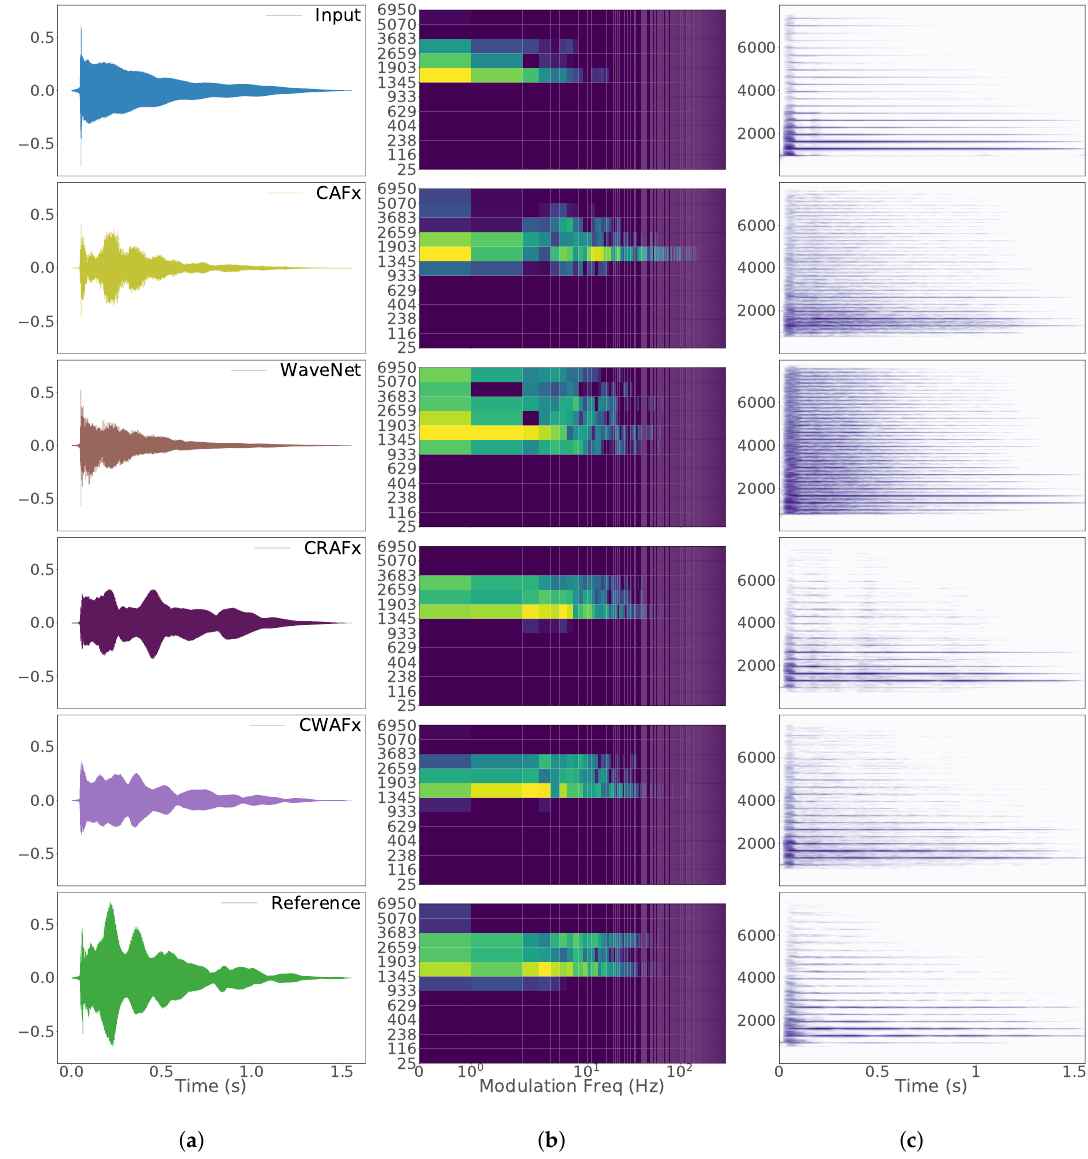
Figure 11. Results with selected samples from the test dataset for the Leslie speaker horn-chorale tasks. ( a ) Waveform, ( b ) modulation spectrum and ( c ) spectogram. Vertical axes represent amplitude, Gammatone frequency (Hz) and FFT frequency (Hz),